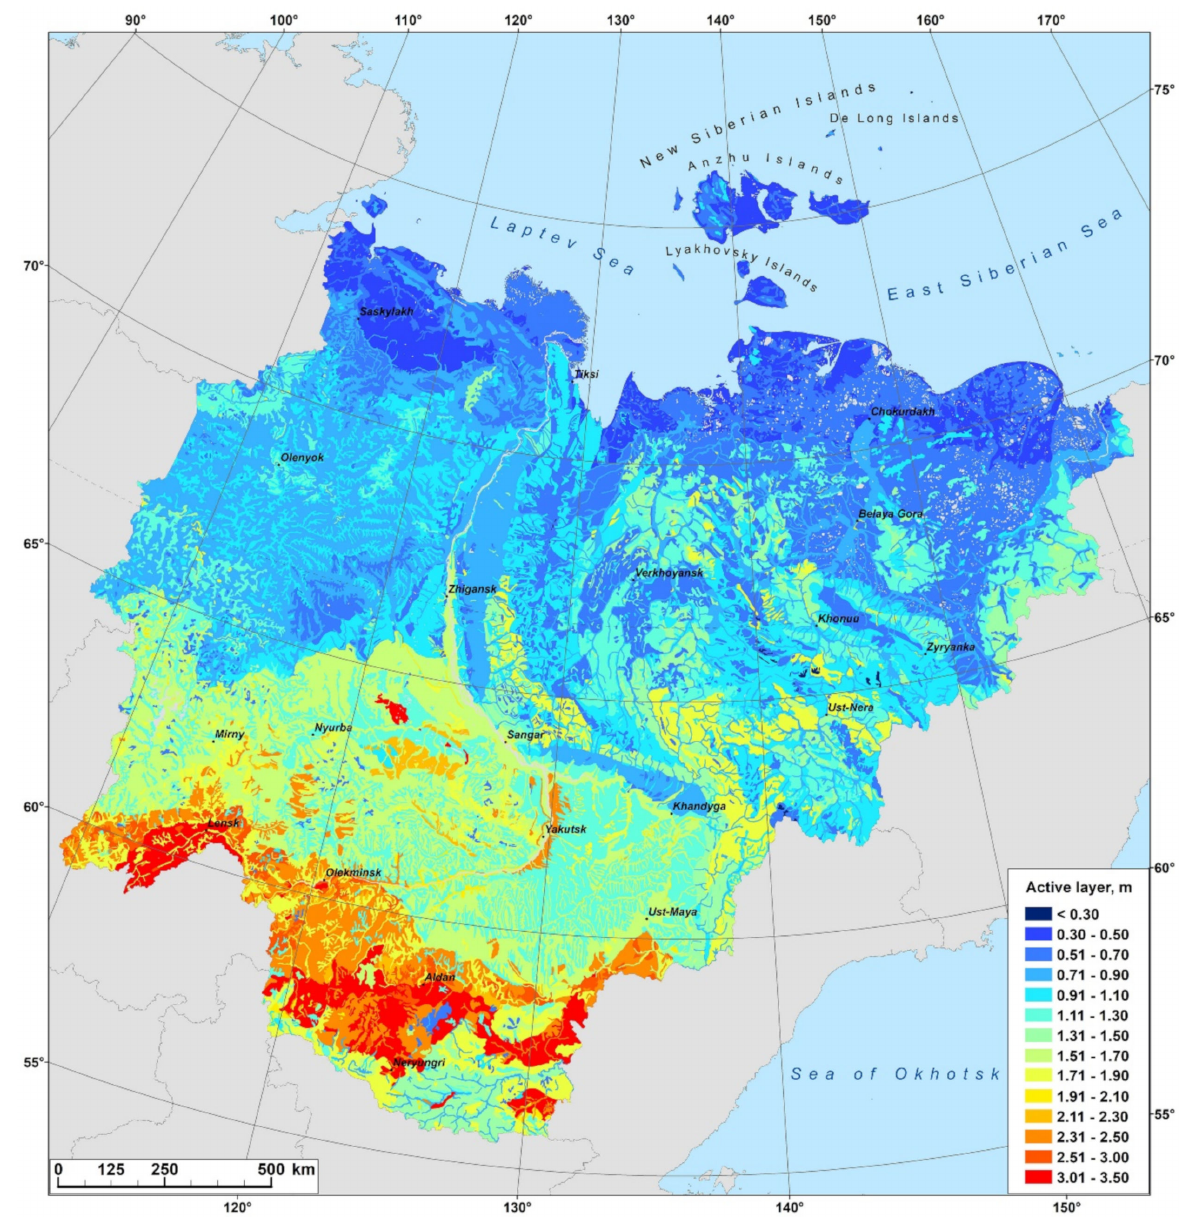
Figure 4. Map of active layer thickness,